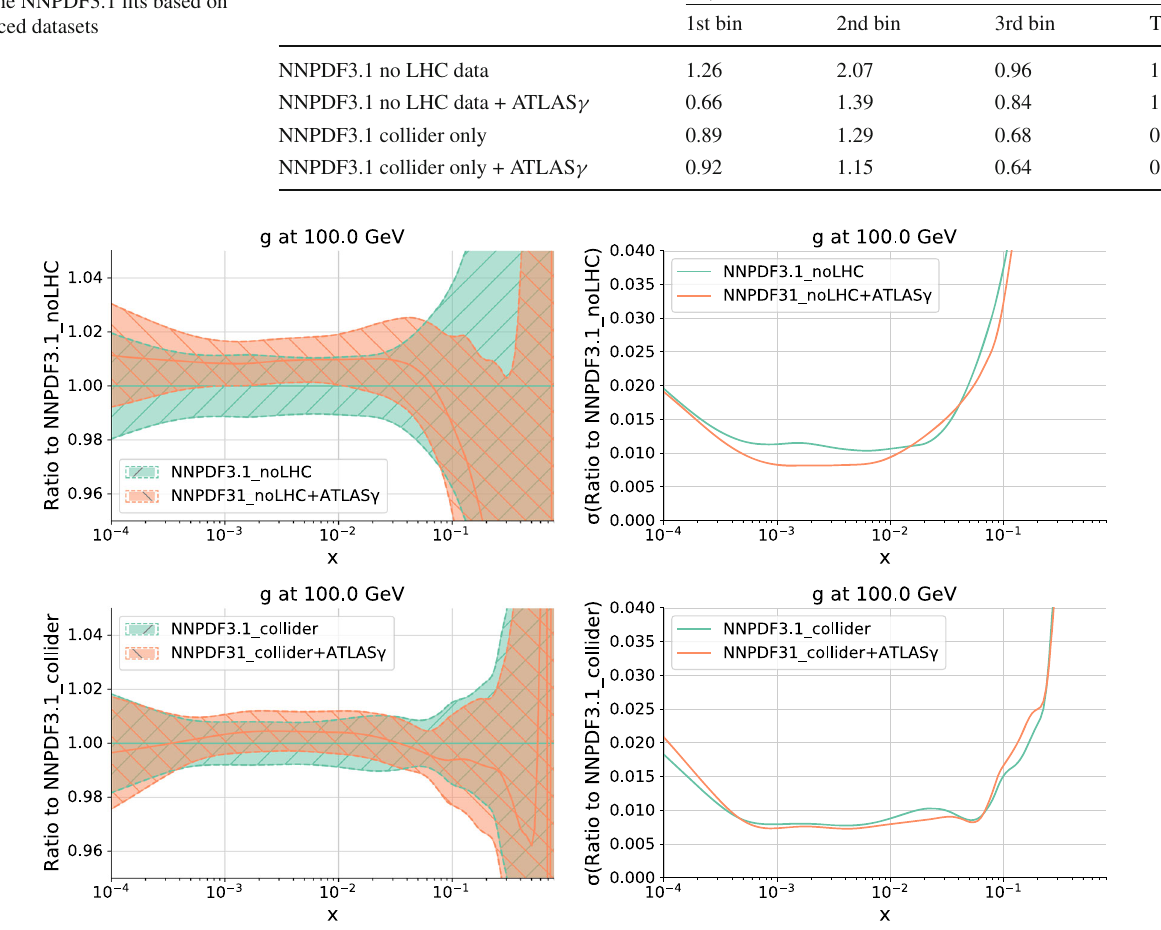
Fig. 9 Same as Fig. 6 for the NNPDF3.1 no-LHC (upper) and collider-only (lower plots)